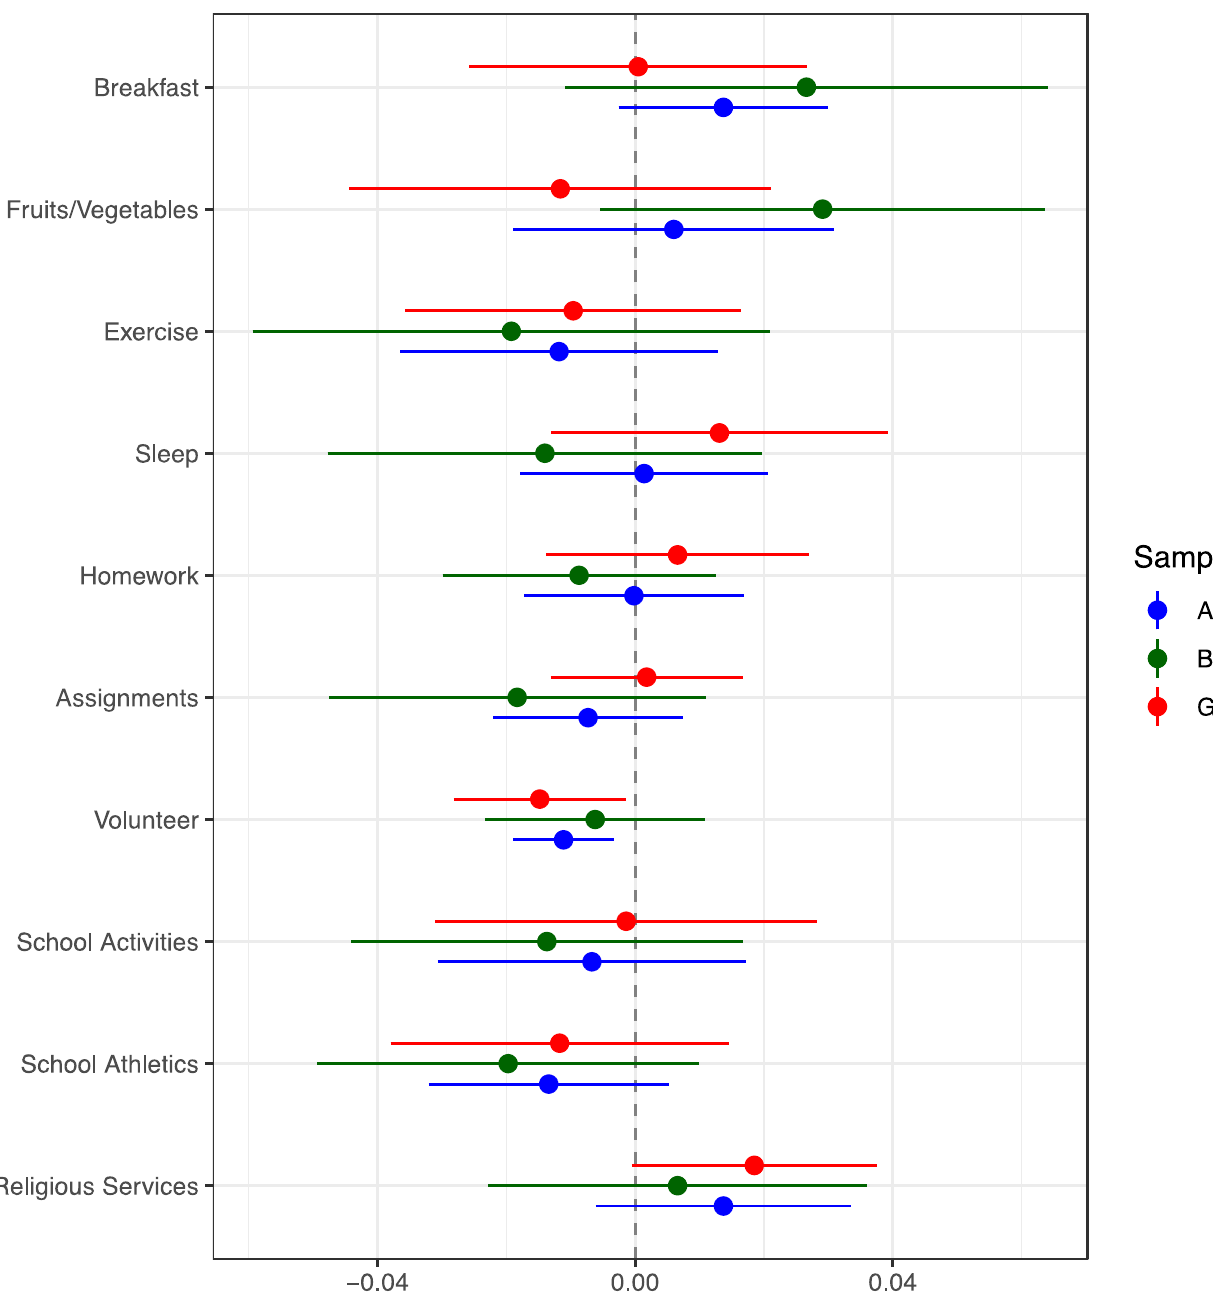
Figure 2. Ordinary Least Squares Difference-in-Difference-in-Differences (DDD) Estimates of the Effects of Welfare Reform on Positive Adolescent Health and Social Behaviors, United States. Notes: The sample consisted of 10th and 12th graders (<age 18 years) whose mothers had a high school education or less. The target group included the subset whose mothers were unmarried, and the comparison group included those whose mothers were married. DDD coefficients of the interaction between the welfare reform and target group indicators ( Π 2 , from Equation (A2) in the Appendix A) are shown, with 95% confidence intervals. The models controlled for the main effects of welfare reform and the characteristics listed in the notes to Figure 1. Sample sizes ranged from 35,430–109,607 (pooled genders), 15,637–48,242 (boys), and 19,793–61,365